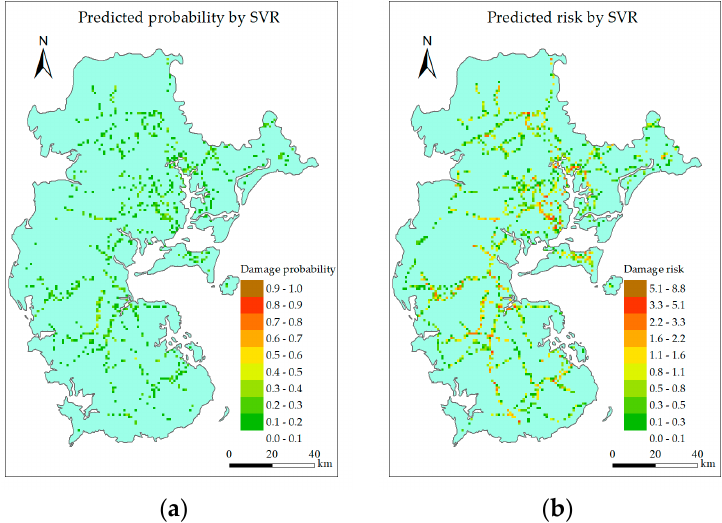
Figure 13. Prediction results of SVR. ( a ) Predicted damage probability. ( b ) Predicted damage risk.